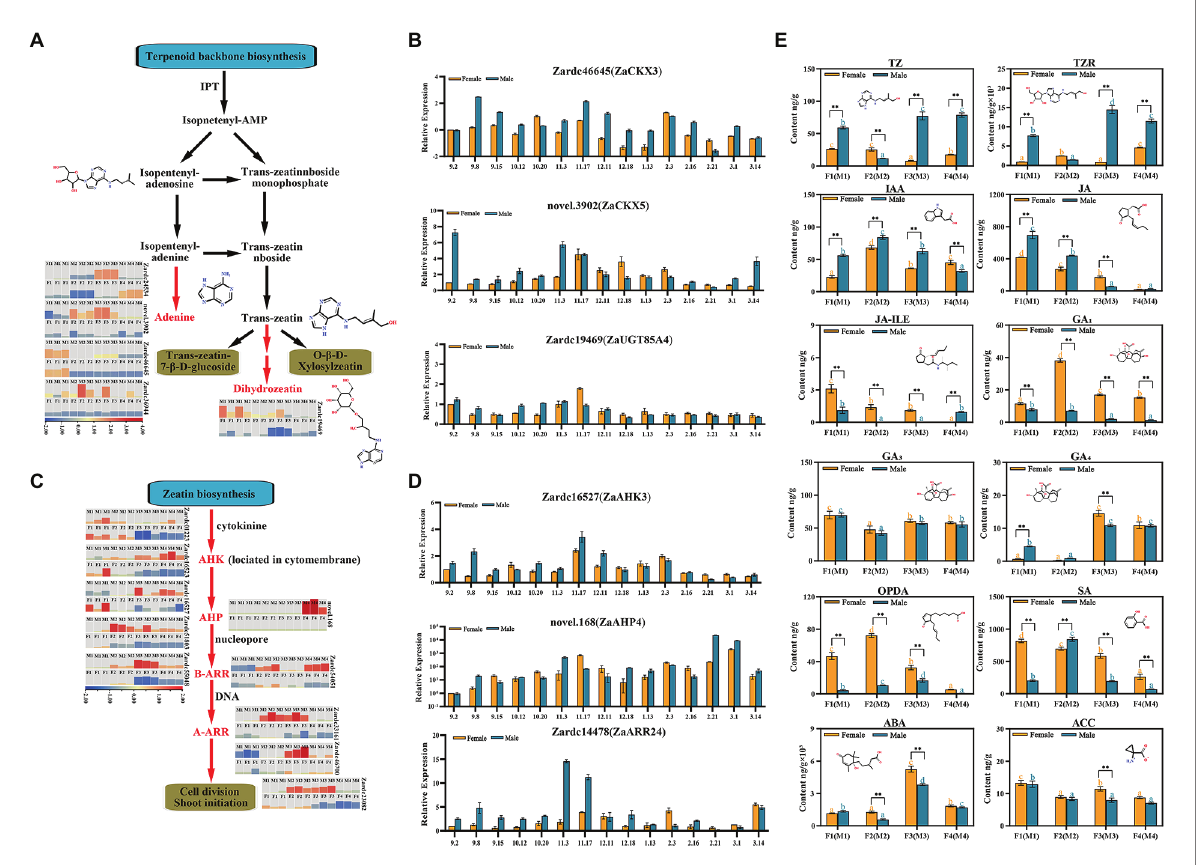
FIGURE 4 The identification of key genes related to cytokinin biosynthesis and signal transduction pathways enriched in male vs. female comparisons. (A) The biosynthesis cascade of zeatin biosynthesis pathway. Red fonts indicated the homologous differential expressed genes significantly up-regulated in this study. (B) The relative expression of the DEGs enriched in zeatin biosynthesis during 15 male and female floral samples. (C) The biosynthesis cascade of zeatin biosynthesis pathway. (D) The relative expression of the DEGs identified in cytokinin signal transduction pathways. (E) The investigation of plant hormones during floral sex differentiation process. * and **, respectively, means p < 0.05 and p < 0.01 between female and male samples. The different orange and blue letters indicated the significant difference ( p < 0.05) among differentiation stages for male or female floral buds,